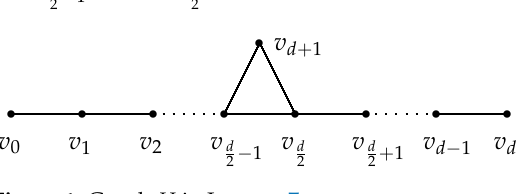
Figure 1. Graph H in Lemma 7.